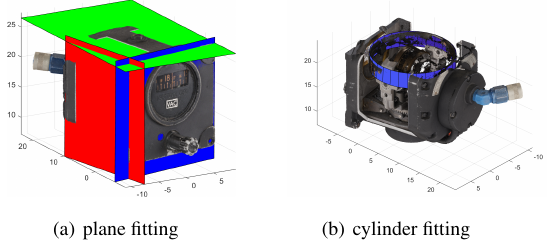
Figure 5. CT 3D model of Figure 3